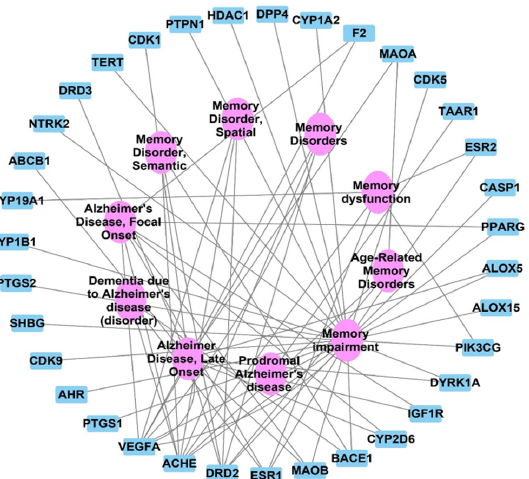
Figure 4. Target genes–Alzheimer and memory disorders network; blue rectangles represent the target genes correlated to memory and Alzheimer diseases; pink oval shapes represent Alzheimer diseases and memory disorders.